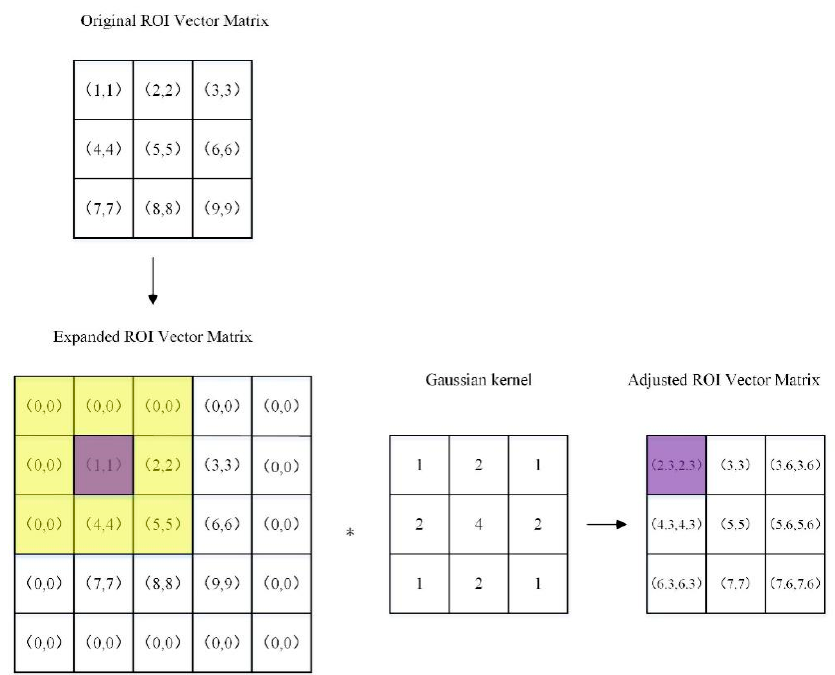
Figure 4. Gaussian kernel computing. The figure reveals that the first step of computing is to expand the original ROI vector matrix R(a,b) to the size of R(a + 2, b + 2) , where the extended part is filled by the 0 vector. Meanwhile, with the convolution kernel weight corresponding to the 0 vector region set as zeros, the ROI vector in the edge of the original matrix can also be computed.